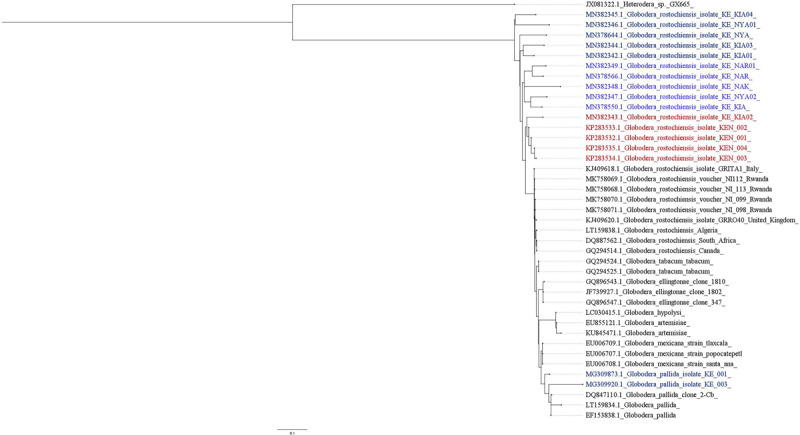
Phylogenetic relation of Kenyan PCN populations compared to those reported in Africa and rest of the world.